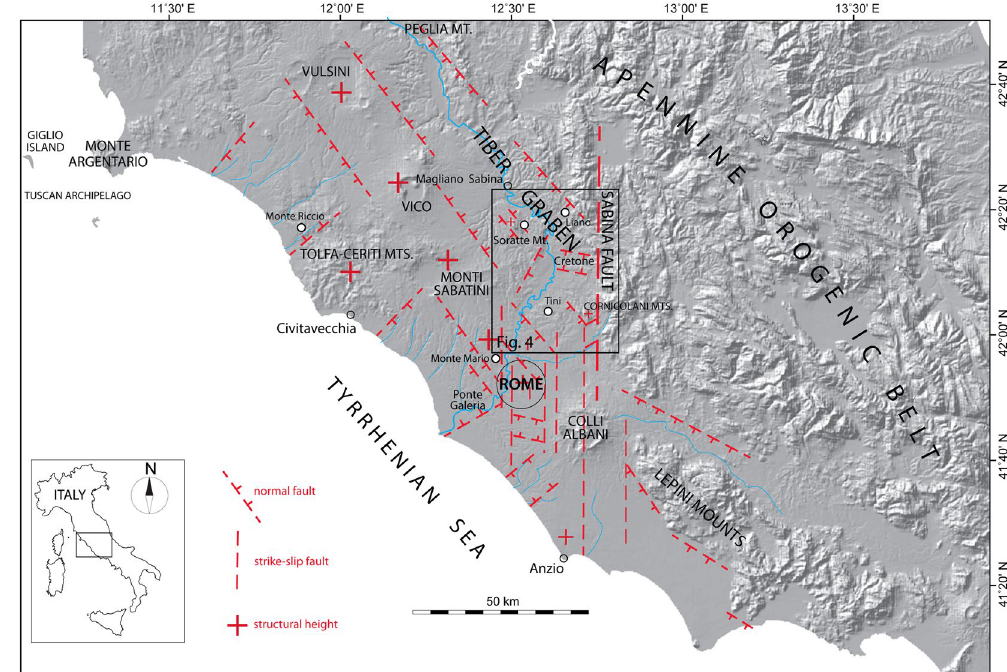
Figure 1. Location map. Digital Elevation Model (DEM) image showing the structural setting of the area on the Tyrrhenian Sea Margin of Latium subjected to continental sedimentation since the late Santernian, and the location of the sites providing biostratigraphic constraints to the Santernian-Emilian sedimentary basins. Modified after TINITALY/01 square WA 6570, used with permission of the Istituto Nazionale di Geofisica e Vulcanologia,